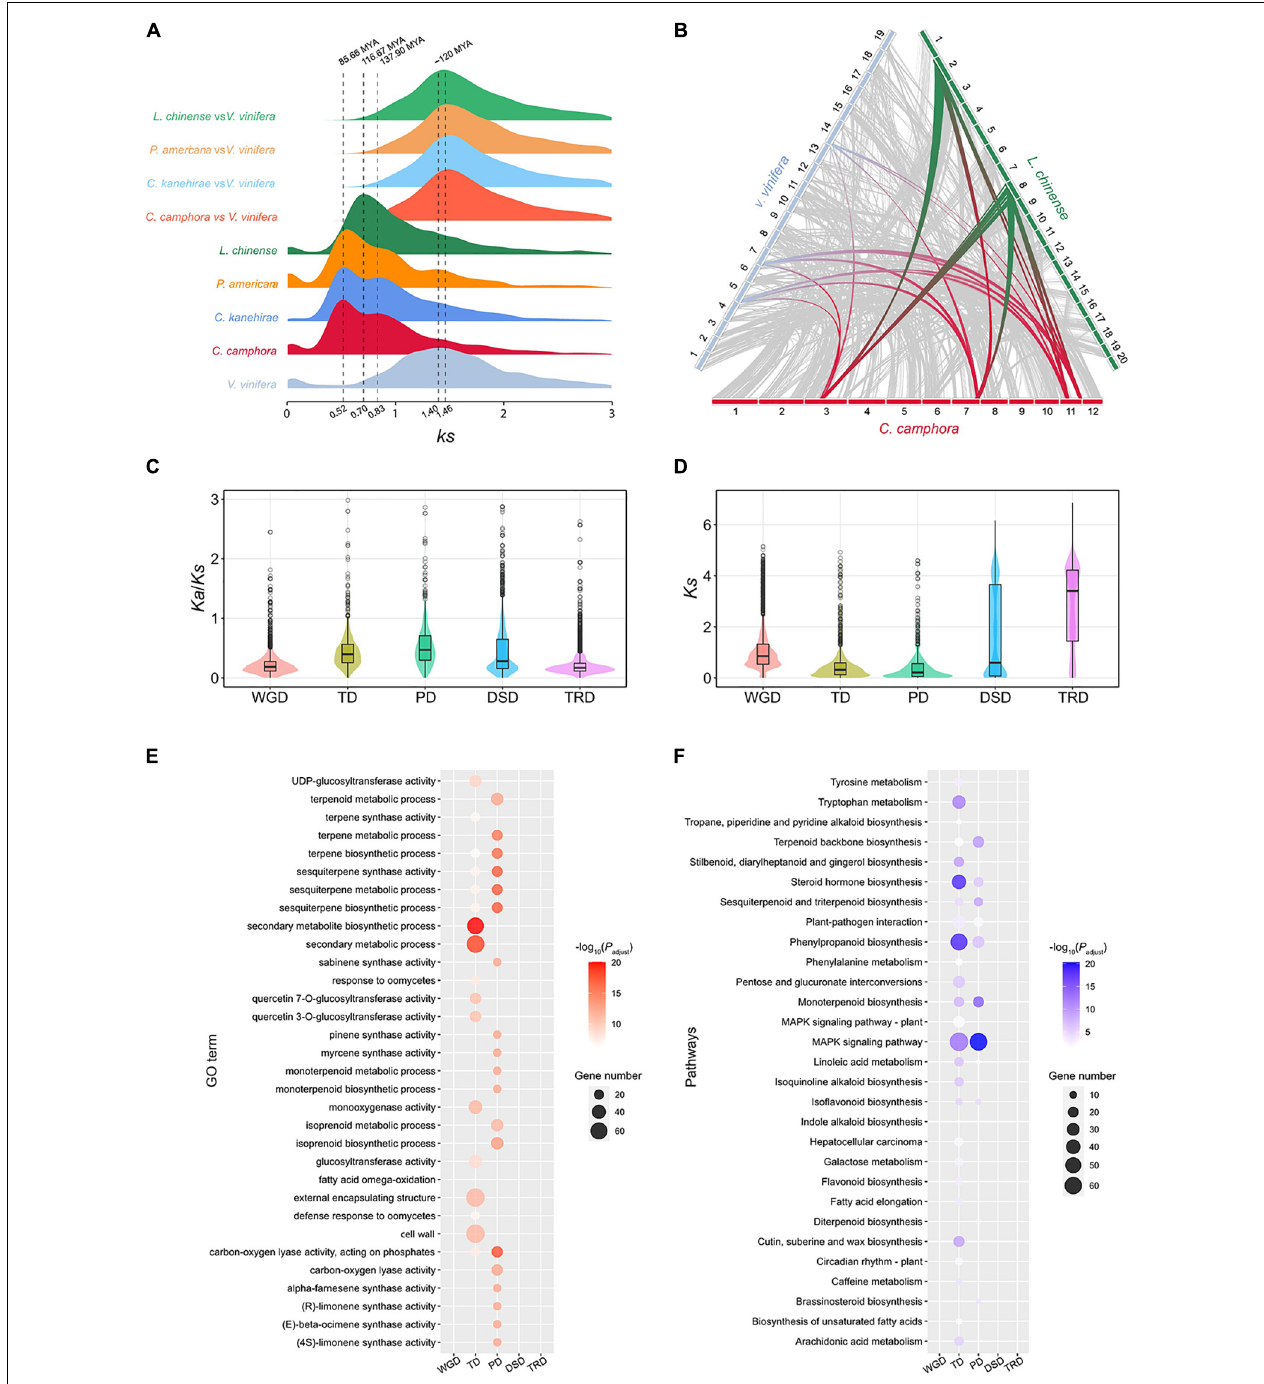
FIGURE 3 | Gene duplication and evolution. (A) Ks distribution of paralogs in magnoliid species ( C. camphora , C. kanehirae , P. americana and L. chinense ) and orthologs between these magnoliids and V. vinifera . (B) Synteny blocks among C. camphora , L. chinense and V. vinifera. (C) Ka / Ks ratio distributions of gene pairs derived from different types of duplication. WGD, whole-genome duplication; TD, tandem duplication; PD, proximal duplication; TRD, transposed duplication; DSD, dispersed duplication. (D) Ks ratio distributions of gene pairs derived from different types of duplication. (E) GO enrichment analyses of genes from different types of duplication. The enriched GO terms with adjusted P -values < 0.01 are presented. The colors of the bubbles indicate the statistical significance of the enriched GO terms. The sizes of the bubbles indicate the number of genes associated with one GO term. (F) KEGG enrichment analyses of genes resulting from different types of duplication. Enriched KEGG pathways with adjusted P- values < 0.01 are presented. The colors of the bubbles represent the statistical significance of enriched KEGG pathways. The sizes of the bubbles indicate the number of genes associated with one KEGG pathway.